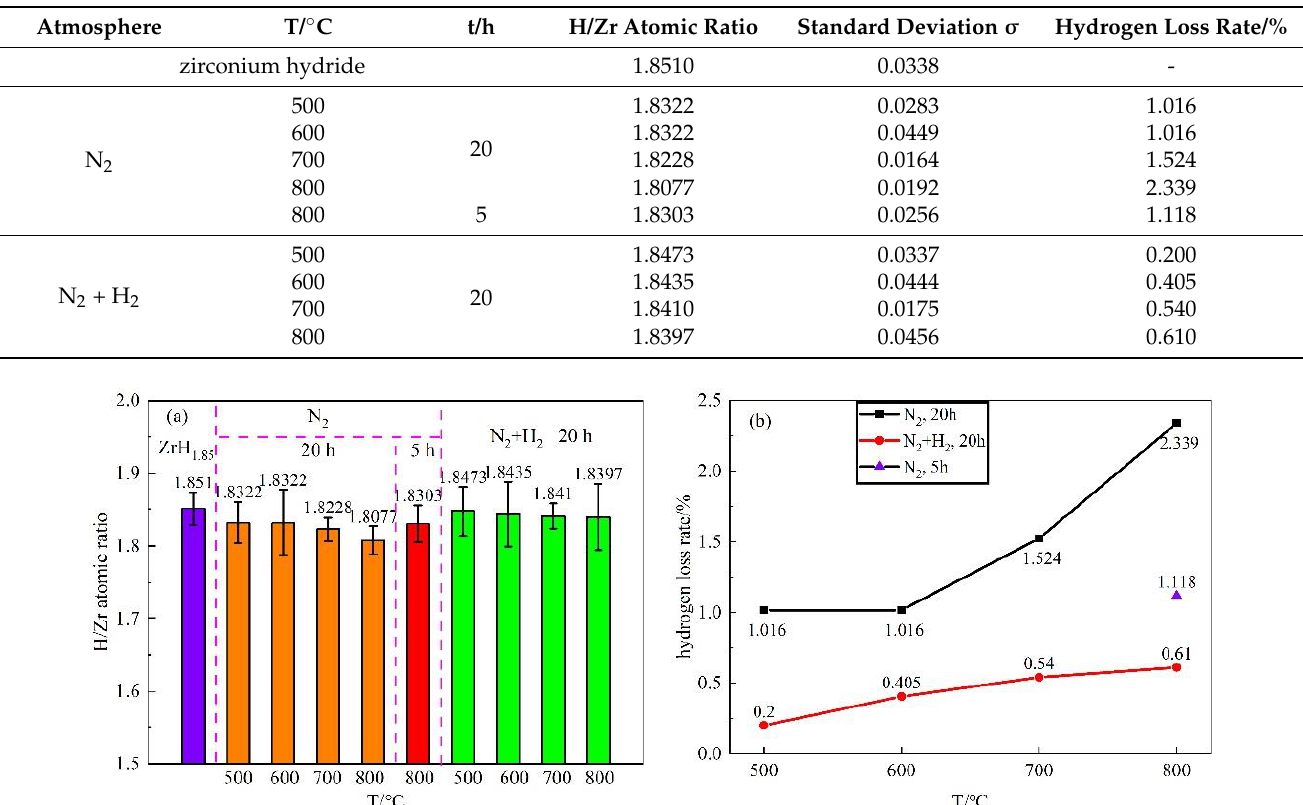
Table 3. H/Zr atomic ratio and hydrogen loss rate of zirconium hydride matrix when film prepared in N 2 and N 2 + H 2 atmosphere.